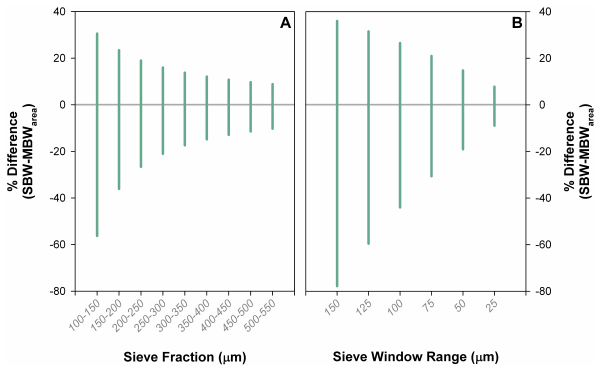
Fig. 4. (A) The theoretical minimum and maximum percentage dif- ference between SBW and MBW area calculated for foraminiferal tests of different sizes sieved using a 50µm window. MBW area is calculated to the midpoint of the size range and tests are assumed to be spherical. The extreme values are determined by assuming all the tests within an aliquot lie at the extreme end of the size range. (B) The difference between SBW and MBW area for different sieve window sizes from 150 to 25µm centred on 300µm. The small- est differences between SBW and MBW area are obtained by using large foraminifera and a small sieve